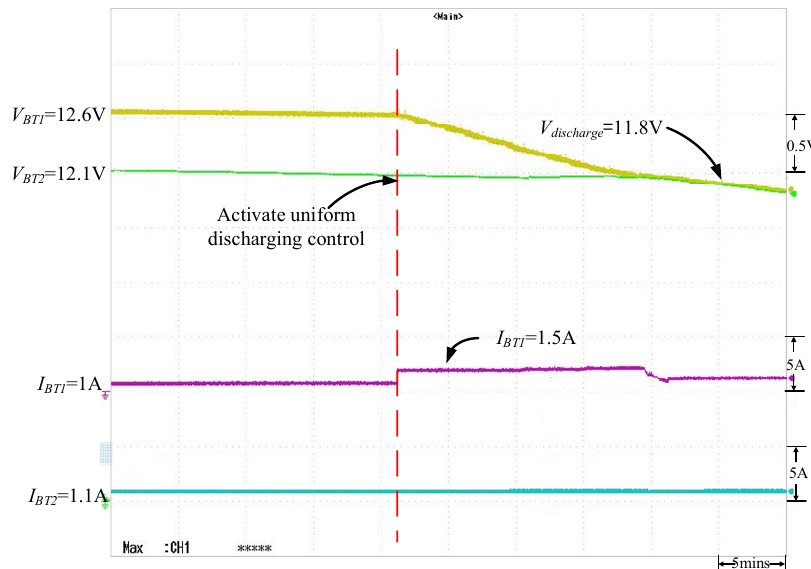
Figure 14. When V BT 1 = 12.6 V, V BT 2 = 12.1 V, the uniform discharge control response.